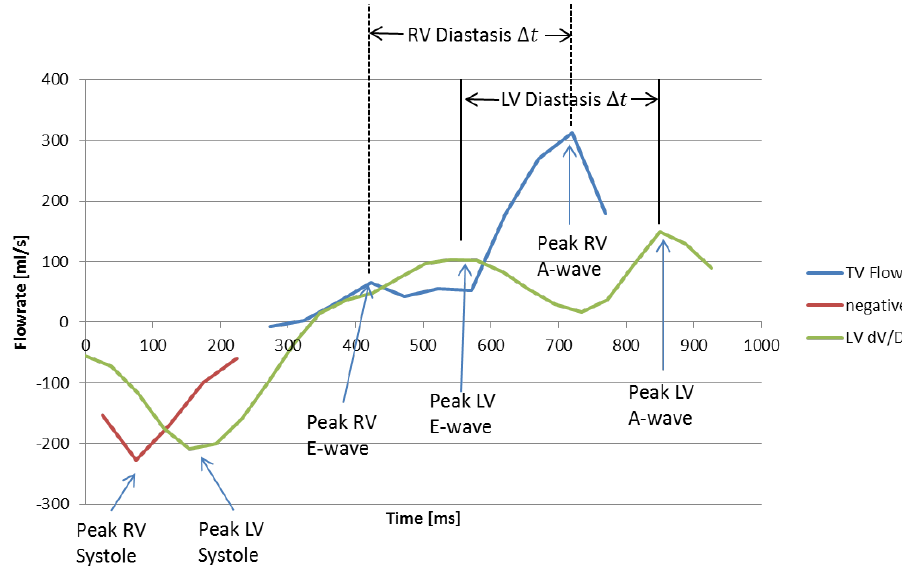
Figure 8. TV and MPA flowrates and time derivative of LV volume for a subject with RVDD. The RV E-wave peak at 410 ms is chosen by working backwards from the RV A-wave by a time equivalent to the LV diastasis ∆𝑡 .